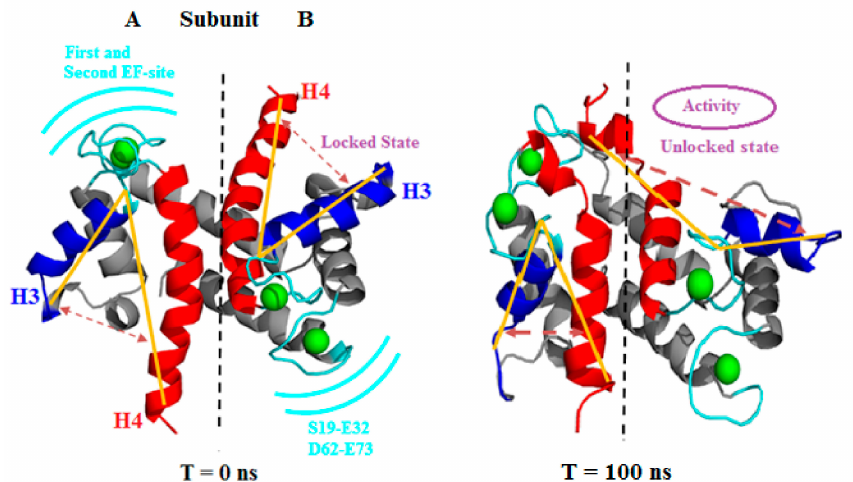
Figure 3. Visualization of first (T = 0 ns) and last (T = 100 ns) frame of the holo (PDB: 2LP3) S100A1 protein. The figure clearly shows the locked and unlocked states in both sides A and B. The yellow lines are drawn to show the expansion of the opening that leads to the unlocked state (hydrophobic patch) and activates the PPI. H3 and H4 of each subunit are colored in blue and red, respectively. The position of the first and second EF site are represented in a cyan color along with a residue range. Ca 2 + are depicted as green